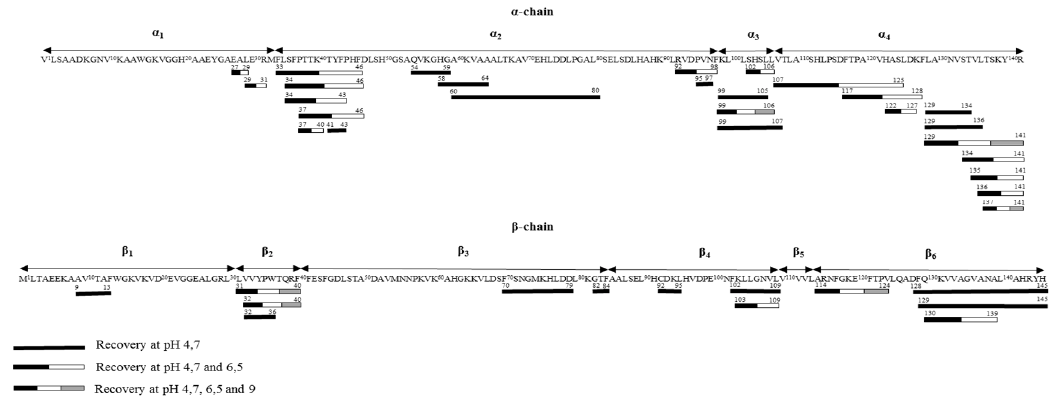
Figure 4. Peptide cartography of pH control recovery (at 4.7, 6.5, and 9) during EDUF treatment. For the α 1 family, two peptides were recovered ( α 27–29 and α 29–31). Their small sizes